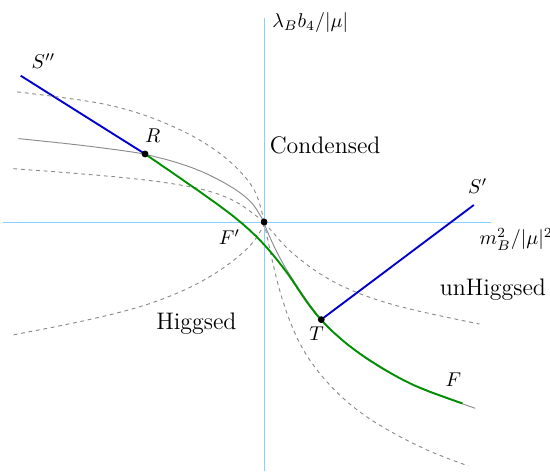
Figure 18 . Foliating parabolas in gray for the phase diagram with x B Increasing the chemical potential at fixed values of UV parameters corresponds to moving along one of these parabolas (the values of the UV parameters determine which one). The parabolas from T to F (green line) and the parabola that pass through R are distinguished. They separate parabolas across which the phase transition to a compressible phase is of second order from those along which the same transition is of first